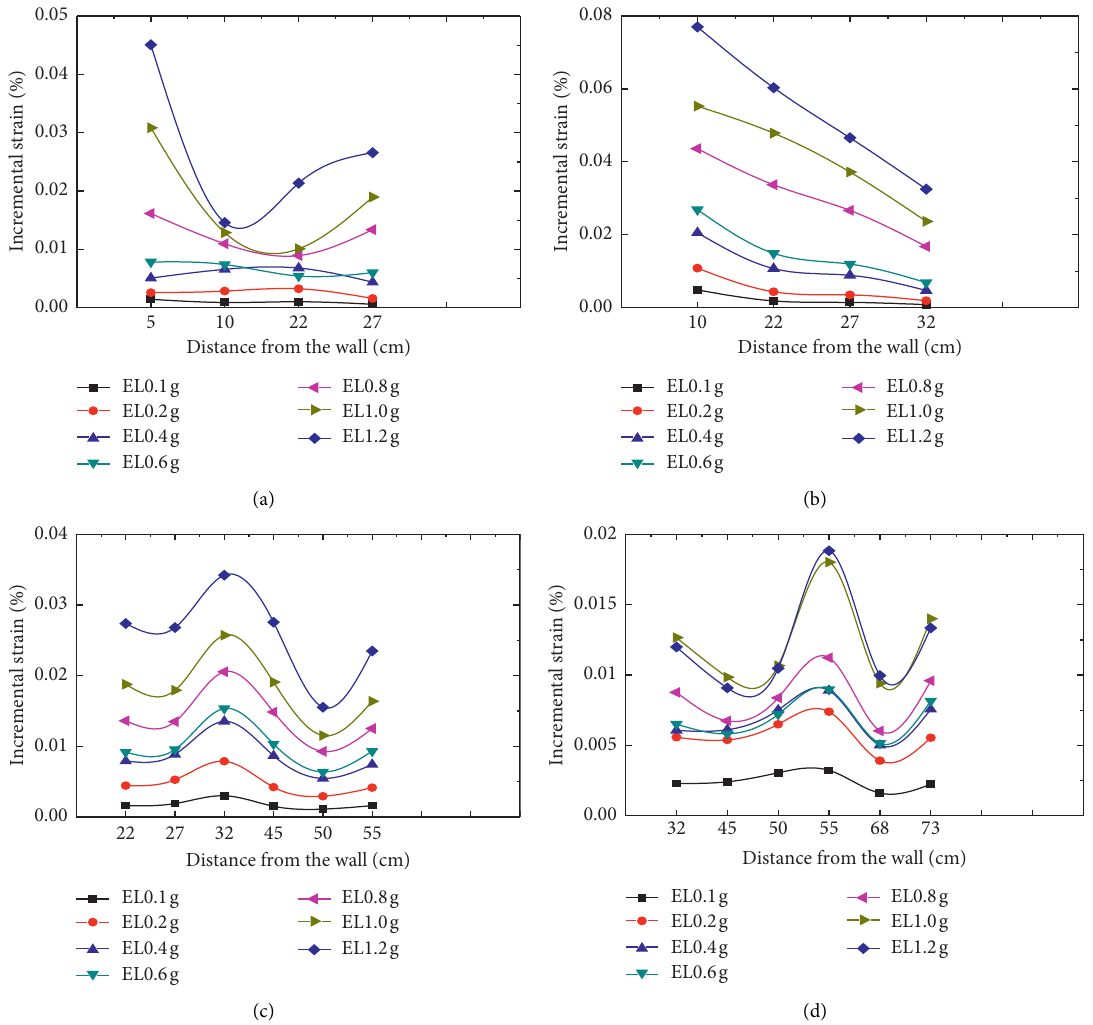
Figure 15: Distributions of strain in reinforcement layers for specimen 2 under EL (model scale: 1/4). (a) L 5. (b) L 6. (c) L 7. (d) L